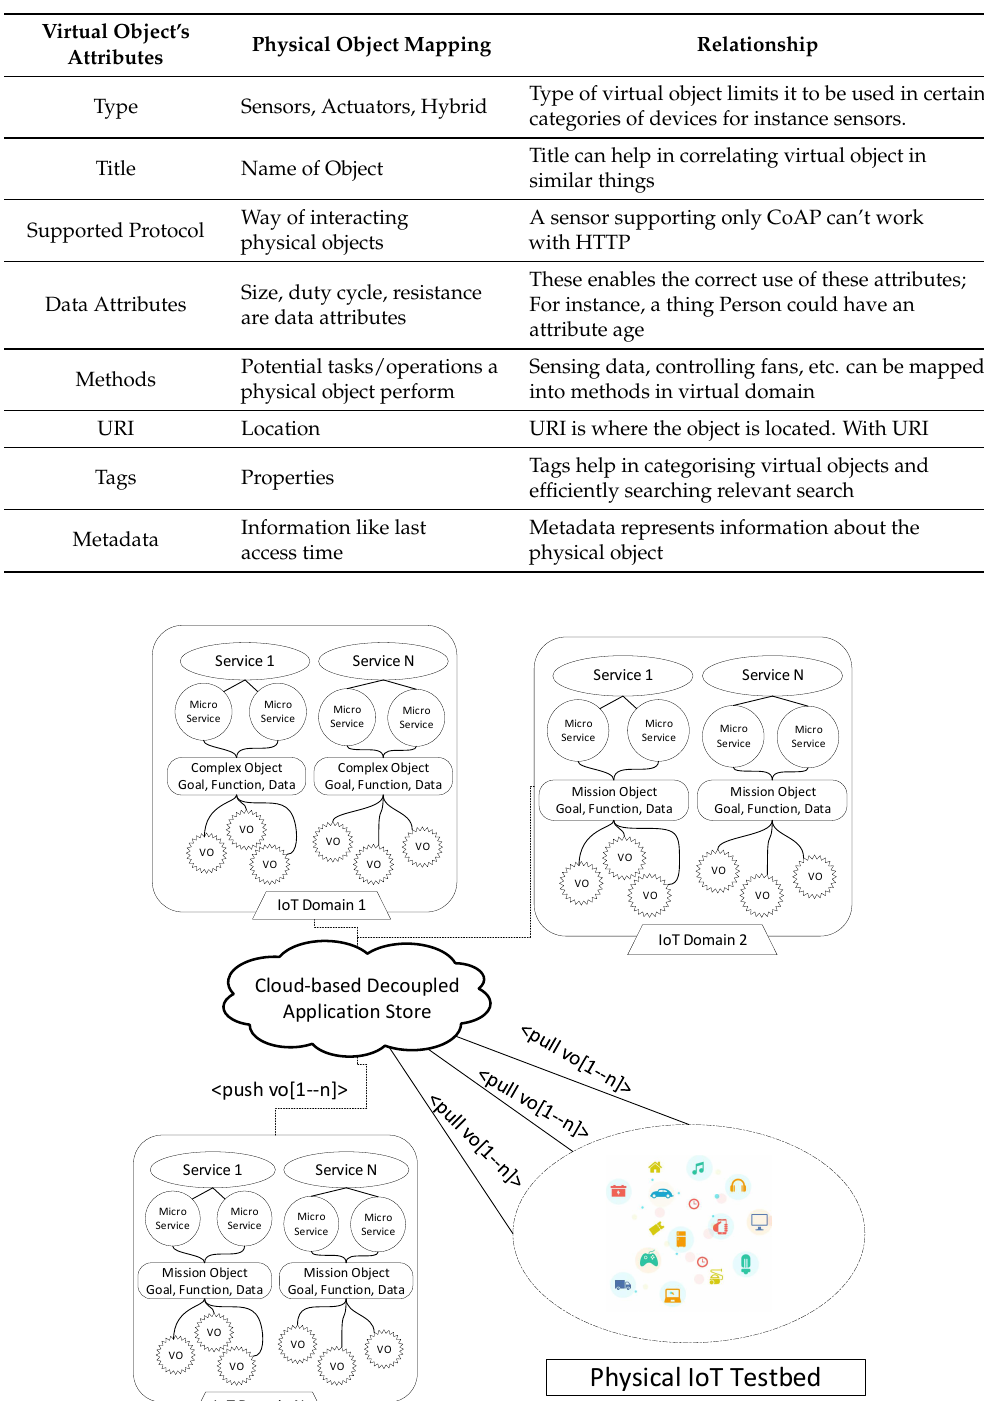
Table 1. Relationship between virtual objects and physical objects.